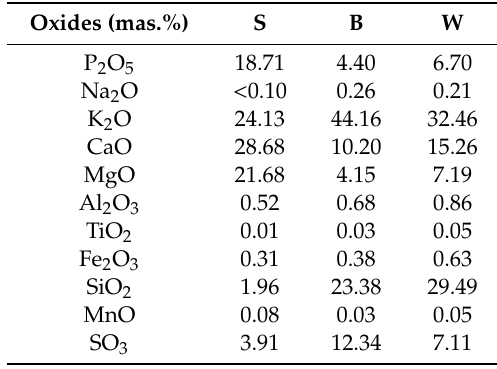
Table 1. Chemical composition of sunflower seed shells (S), barley (B) and wheat straw fly ash (W). Oxides (mas.%)